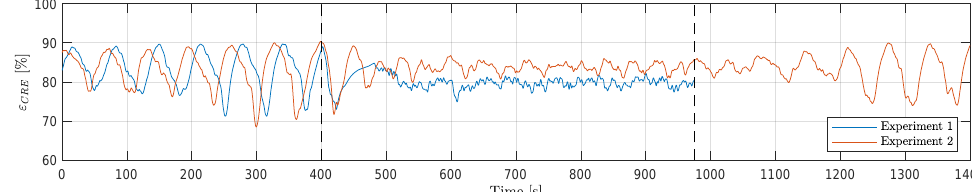
Figure 12. Oil removal efficiency during both experiments.